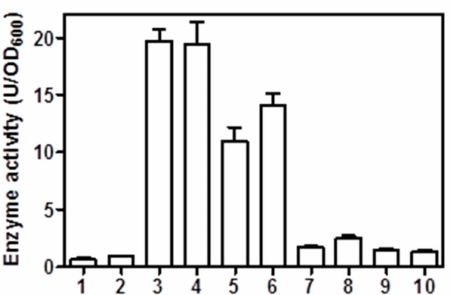
Figure 5. Phenolic acid decarboxylase activity of the surface-displayed cells. 1 and 2: BL21(DE3) and BL21(DE3)pLysS3 cells carrying a blank pET-22b vector, respectively; 3 and 4: BL21(DE3) and BL21(DE3) pLysS cells carrying a pET22b-pelblpad vector, respectively; 5 and 6: BL21(DE3) and BL21(DE3) pLysS cells carrying a pET22b-gdslblpad vector; 7 and 8: proteinase K treated BL21(DE3) and BL21(DE3) pLysS cells carrying a pET22b-pelblpad vector, respectively; and 9 and 10: proteinase K treated BL21(DE3) and BL21(DE3) pLysS cells carrying a pET22b-gdslblpad vector,